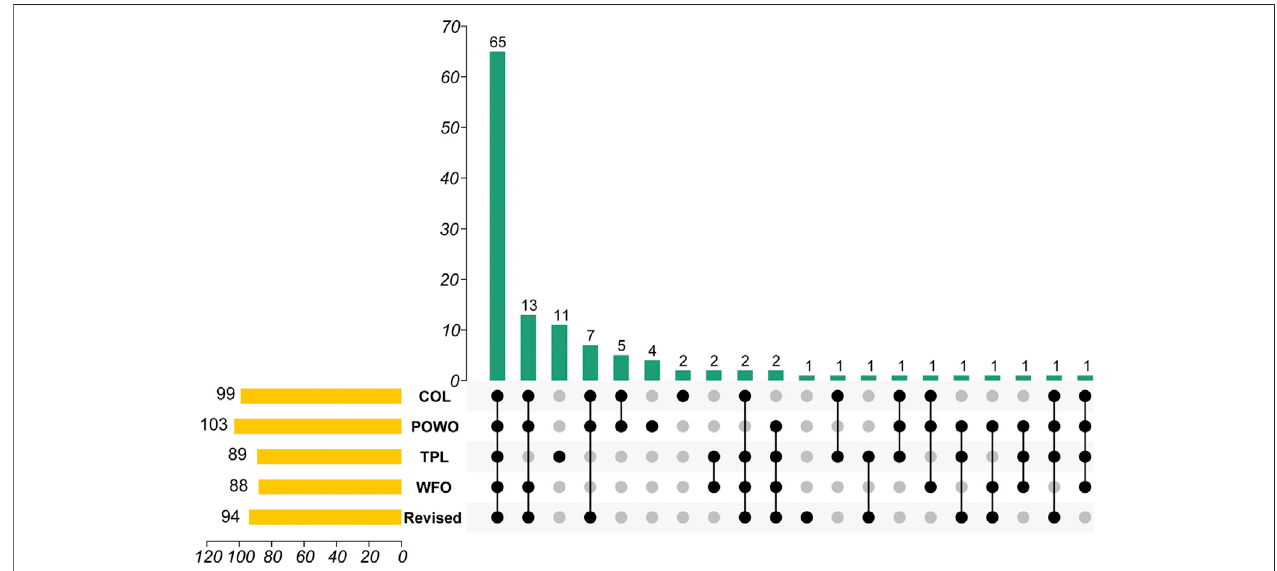
FIGURE 1 | An UpSet graph of Lycium spp. among databases covering species. Data source: Catalogue of Life (COL), Plants of the World Online (POWO), World Flora Online (WFO), and the Plant List (TPL). The bottom part indicates the coverage of individual species in the respective databases. For example, the second vertical barindicatesthatthereare13specieslistedinfour(COL,POWO,WFO,andRevised)ofthe fi vedatabases,excludingTPL,whilethethirdverticalbarindicateselevenare only found in TPL.